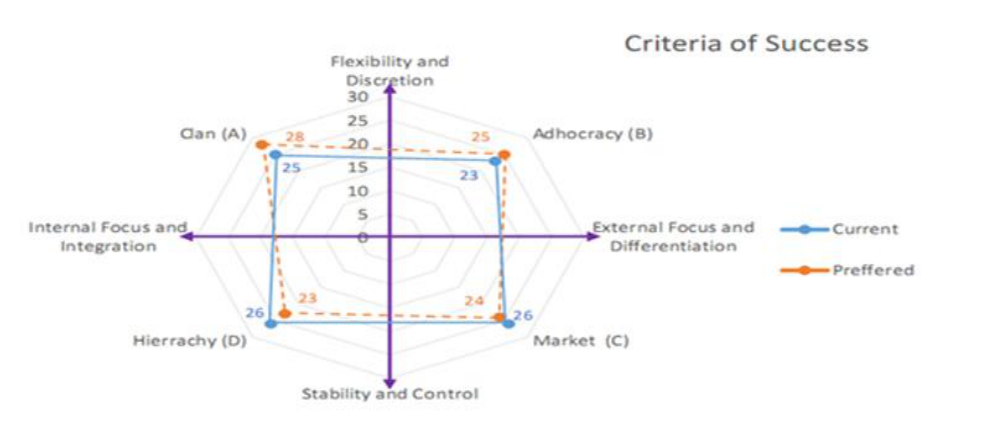
Figure 9. Radar diagram of dimension of criteria of